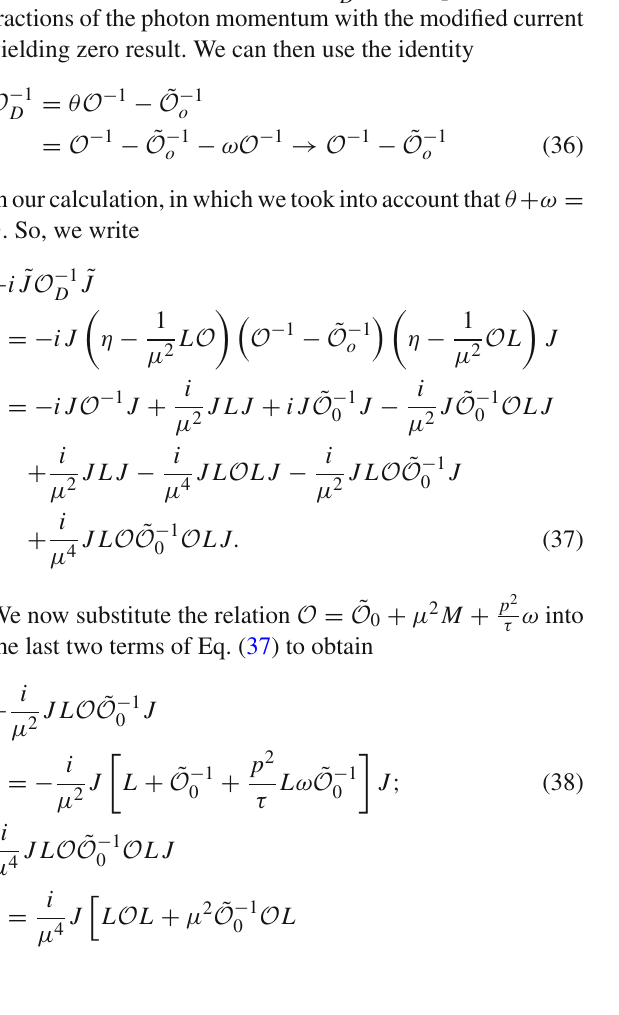
graphically in Fig. 2, which does not show the crossed dia-